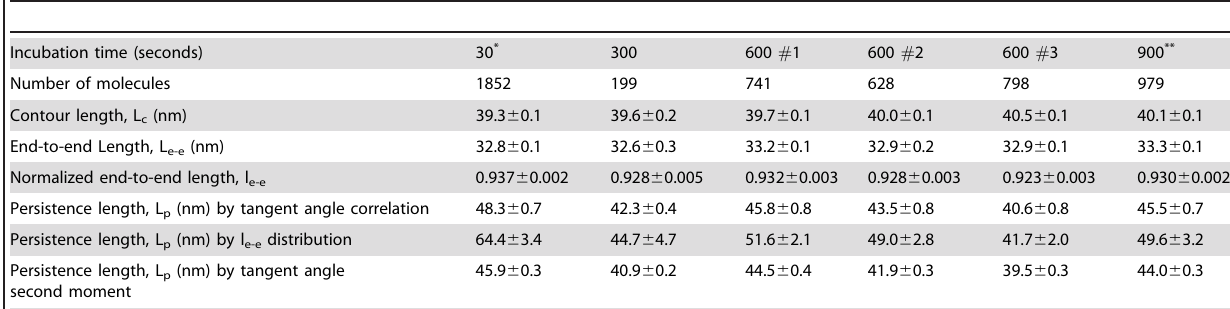
Table 1. Summary of L c , L e-e , and L p from tangent angle correlation, second moment and end-to-end length analyses.